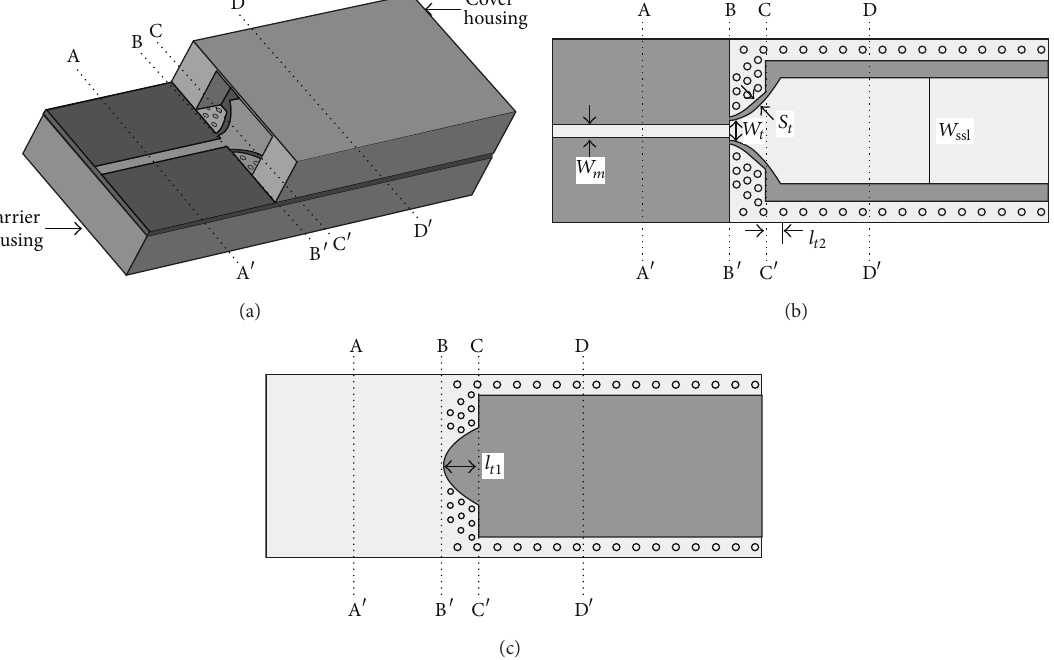
8 mil thickness is used as a circuit substrate (𝜀 𝑟 = 3.38)